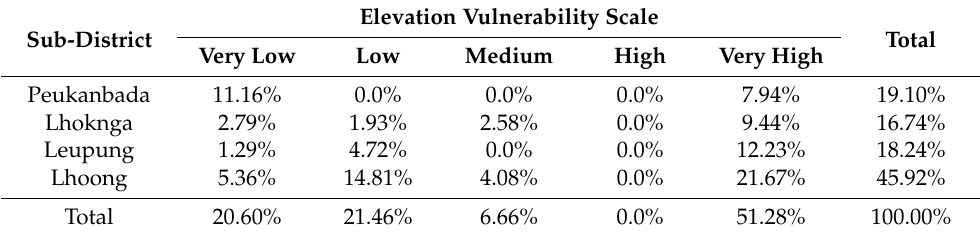
Figure 4. Level of elevation vulnerability based on DEMNAS . Table 5. Percentage of coastal vulnerability in terms of coastal elevation .